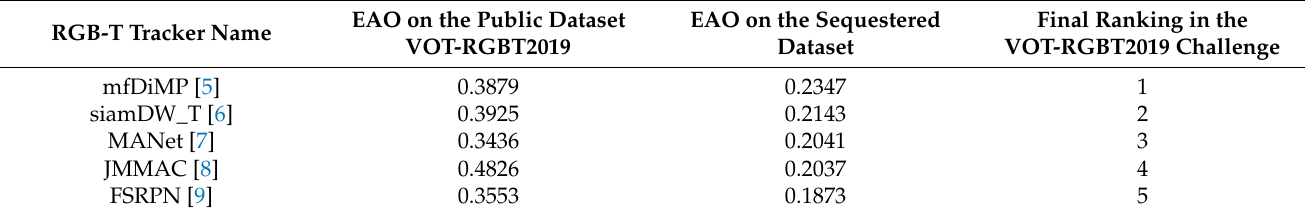
Table 1. The Top 5 EAO in the VOT-RGBT2019